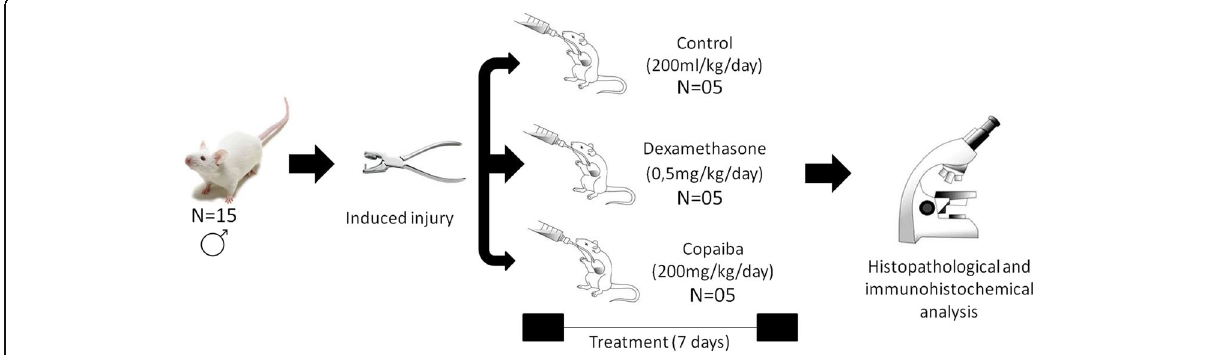
Fig. 1 Schematic representation of the experimental design utilized in the present